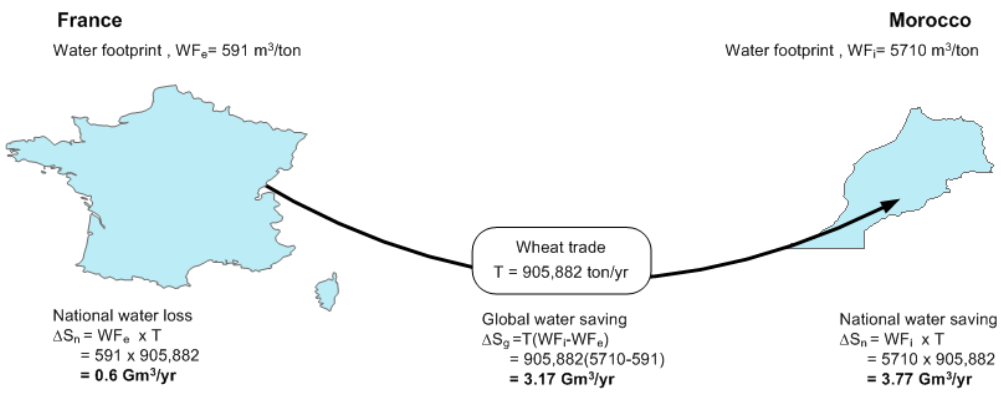
Fig. 3. Global water saving through the trade in durum wheat from France to Morocco. Period: 1996–2005.